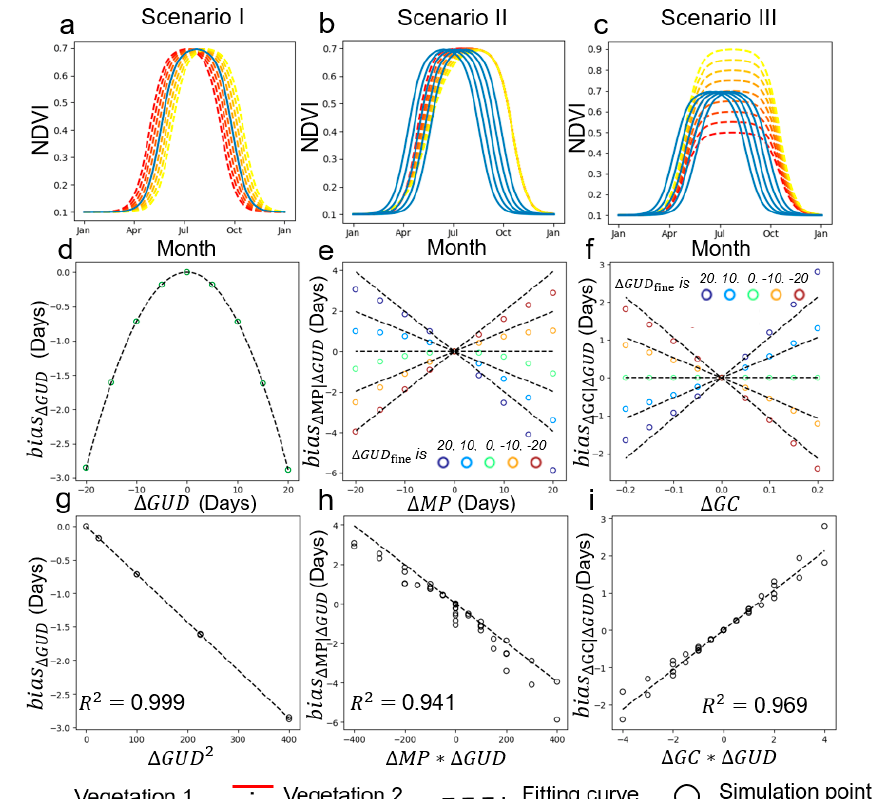
Figure 2. Results of the simulation experiments (three scenarios) exploring the function forms of three variables in Equation (11). ( a – c ) VI Curves 1 (blue) and 2 (red to yellow) in Scenarios I, II, and III. ( d – f ) bias ∆ GUD , bias ∆ MP , and bias ∆ GC change with the corresponding factors. | ∆ GUD | ∆ GUD fine fine fine fine fine The negative values of ∆ MP fine and positive ∆ GC fine indicate faster growth speed of pixel 1 than that of pixel 2. The di ff erent color of point refers to di ff erent levels of ∆ GUD fine (i.e., − 20, − 10, 0,10 and 20 days) and the negative ∆ GUD fine values indicate earlier green-up date ( GUD ) of pixel 1 than that of pixel 2. The dashed lines represent the proposed function forms (Equations (12) and (13)) used to fit these bias values. ( g – i ) Fitting performance of each function form,